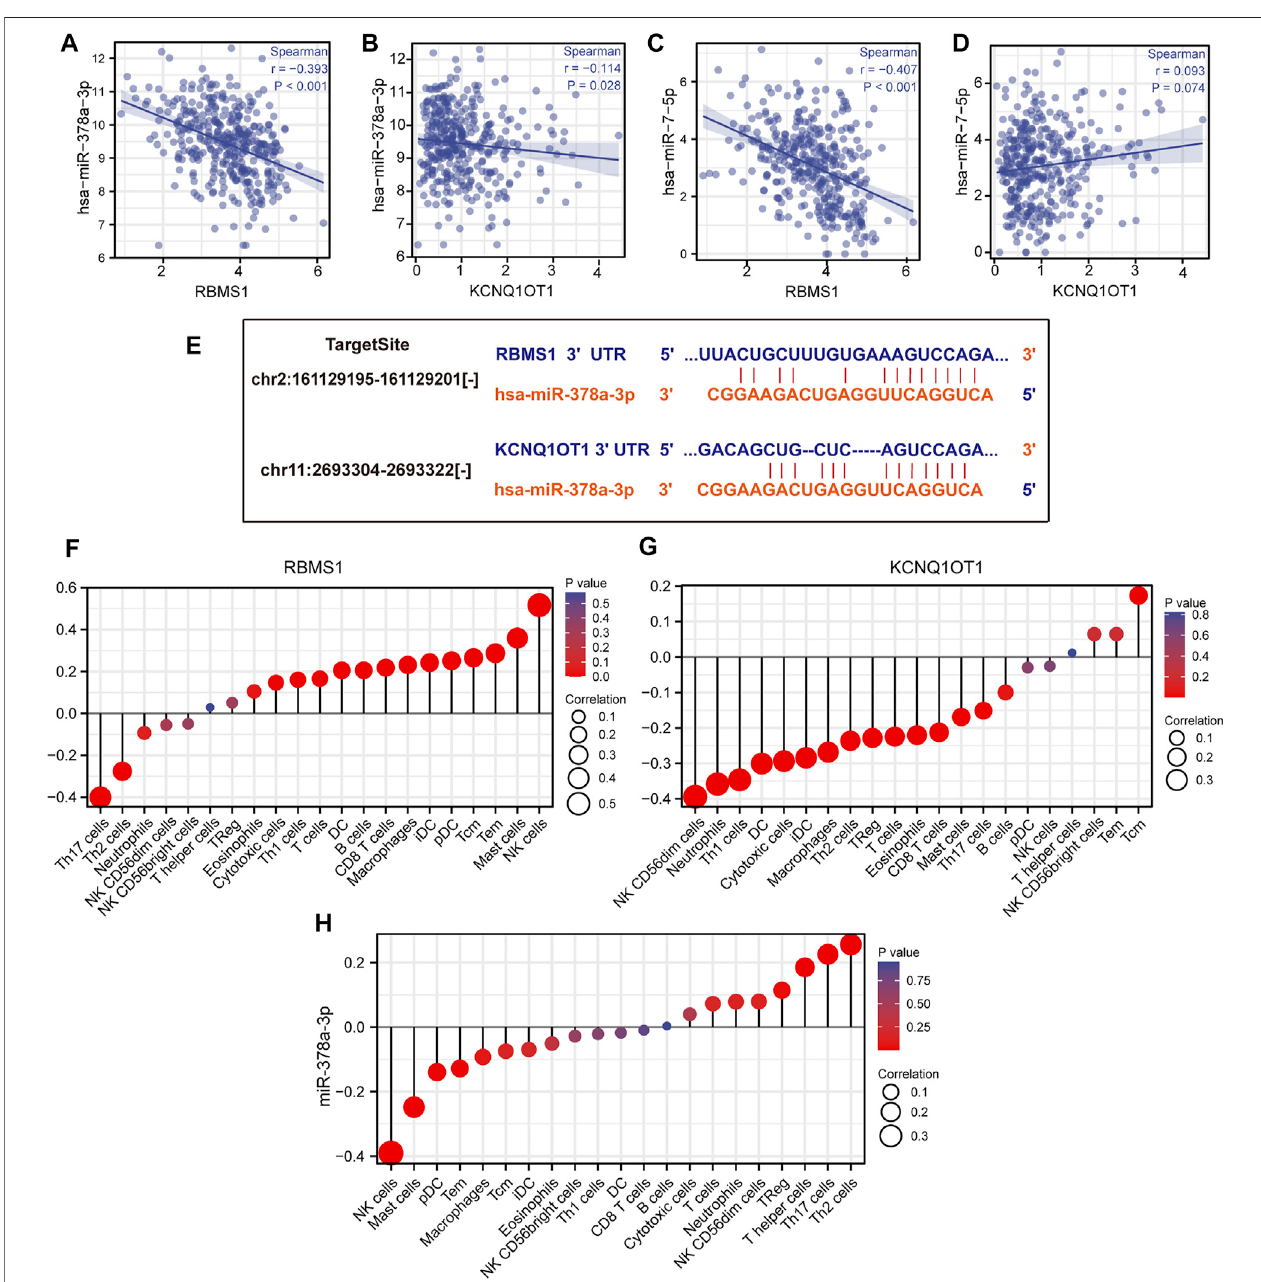
FIGURE 7 | Identi fi cation of the KCNQ1OT1/miR-378a-3p/RBMS1 axis. (A – D) Scatter plots showing miRNA-target co-expression of hub genes associated with prognosis. (E) Binding site prediction for the KCNQ1OT1/miR-378a-3p/RBMS1 axis. (F – H) Correlation analysis of the KCNQ1OT1/miR-378a-3p/RBMS1 axis with in fi ltrating immune